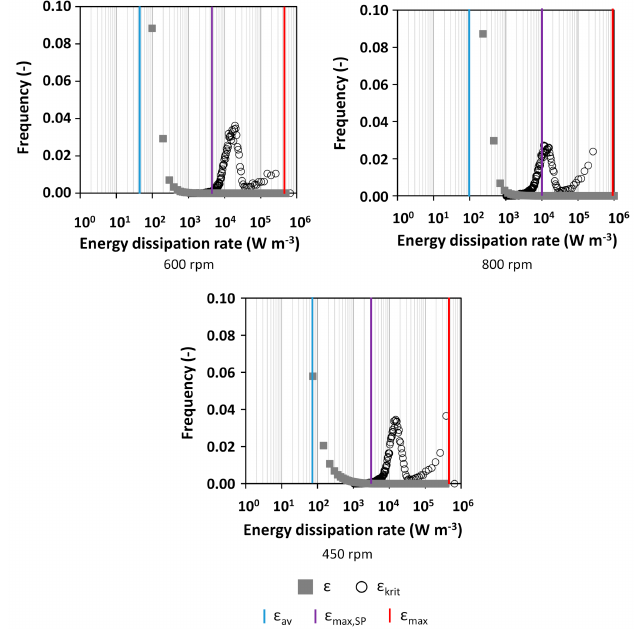
Figure 9. Critical energy dissipation rate distributions (black circles) compared to the energy dissipa- tion rate distribution in the SIS (600 rpm and 800 rpm) and in the TIS (450 rpm) (grey squares). The averaged energy dissipation rates from CFD simulations are indicated in blue, their maxima in red. Maximum energy dissipation rates calculated from slice plots are indicated in purple.